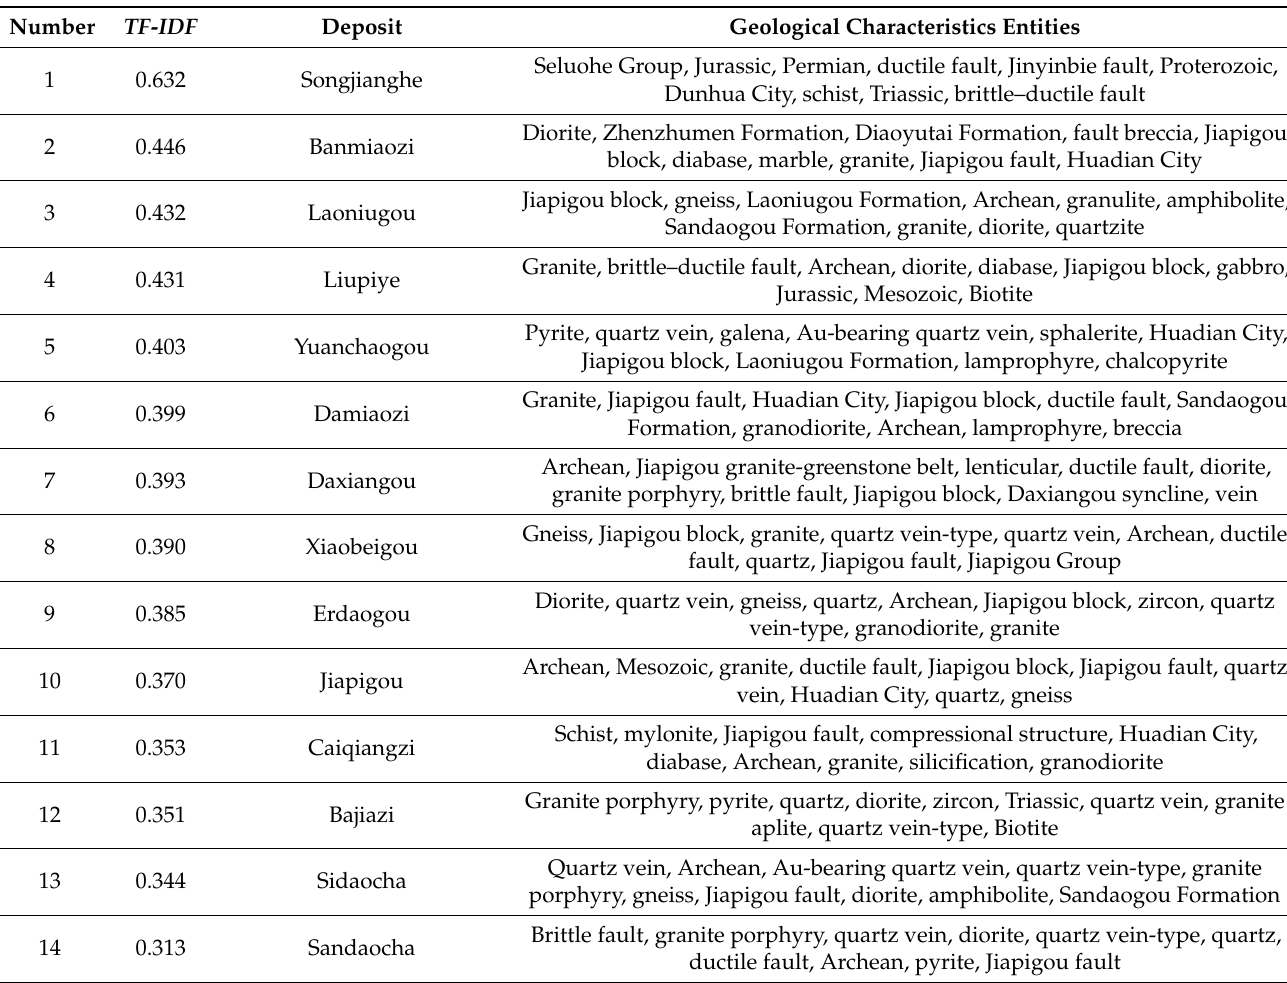
Table 10. The TF - IDF values of the top 10 geological characteristic